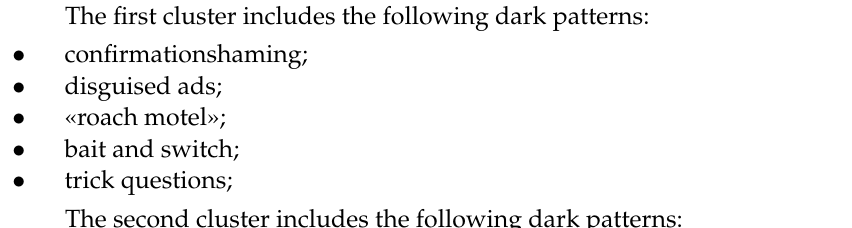
Figure 8. The result of hierarchical clustering into 6 clusters. *—hclust command